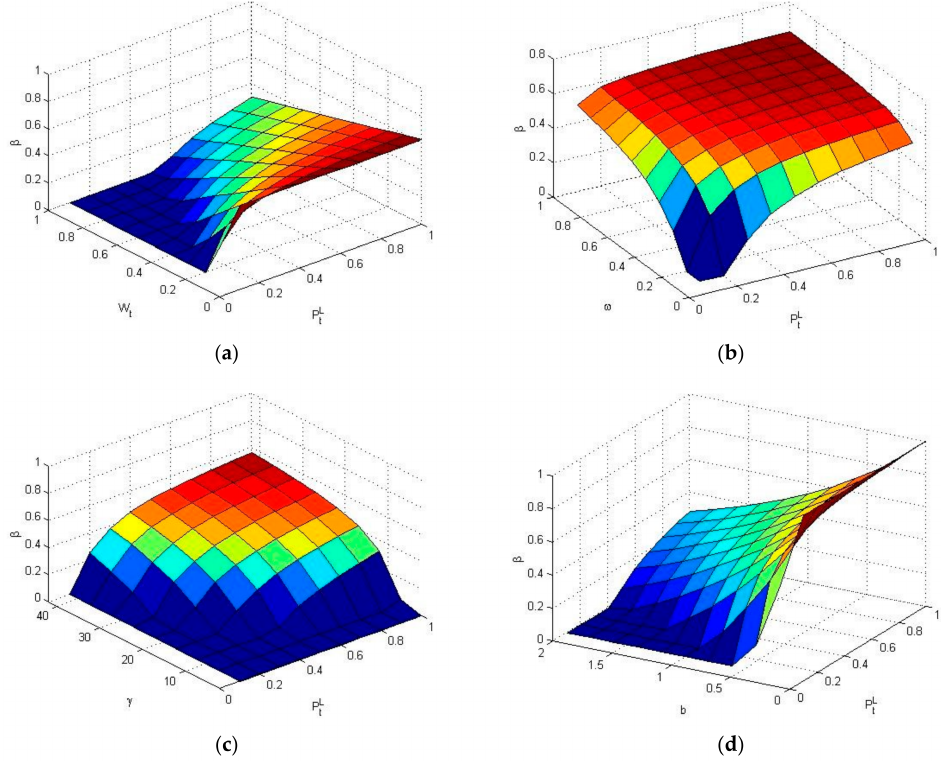
Figure 4. The land marginal return of enterprises and OPPSC under ( a ) different wages, ( b ) different proportions of land increment income in land transfer fee, ( c ) different expected return rates of the stock capital and ( d ) different marginal utility elasticities of the lump-sum currency